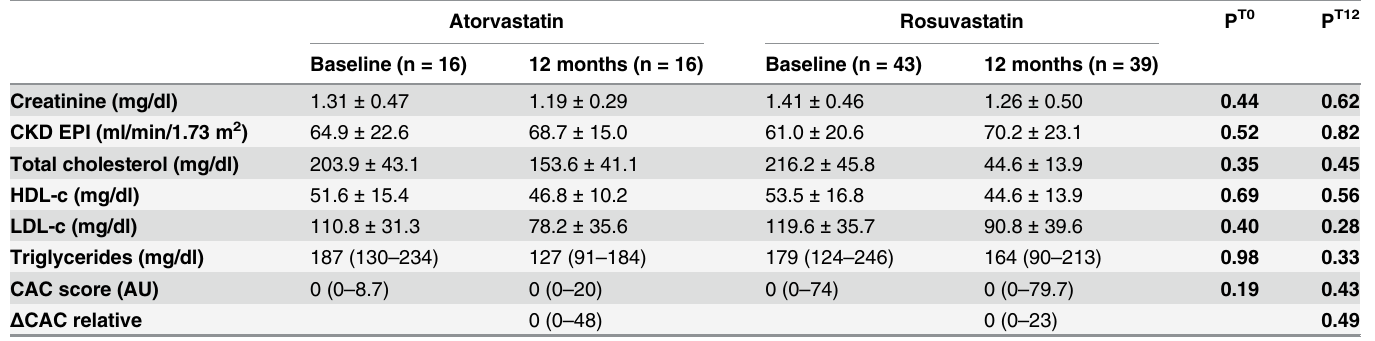
Table 2. Comparison on rosuvastatin and atorvastatin beteween the groups. Atorvastatin Rosuvastatin P T0 Baseline (n =